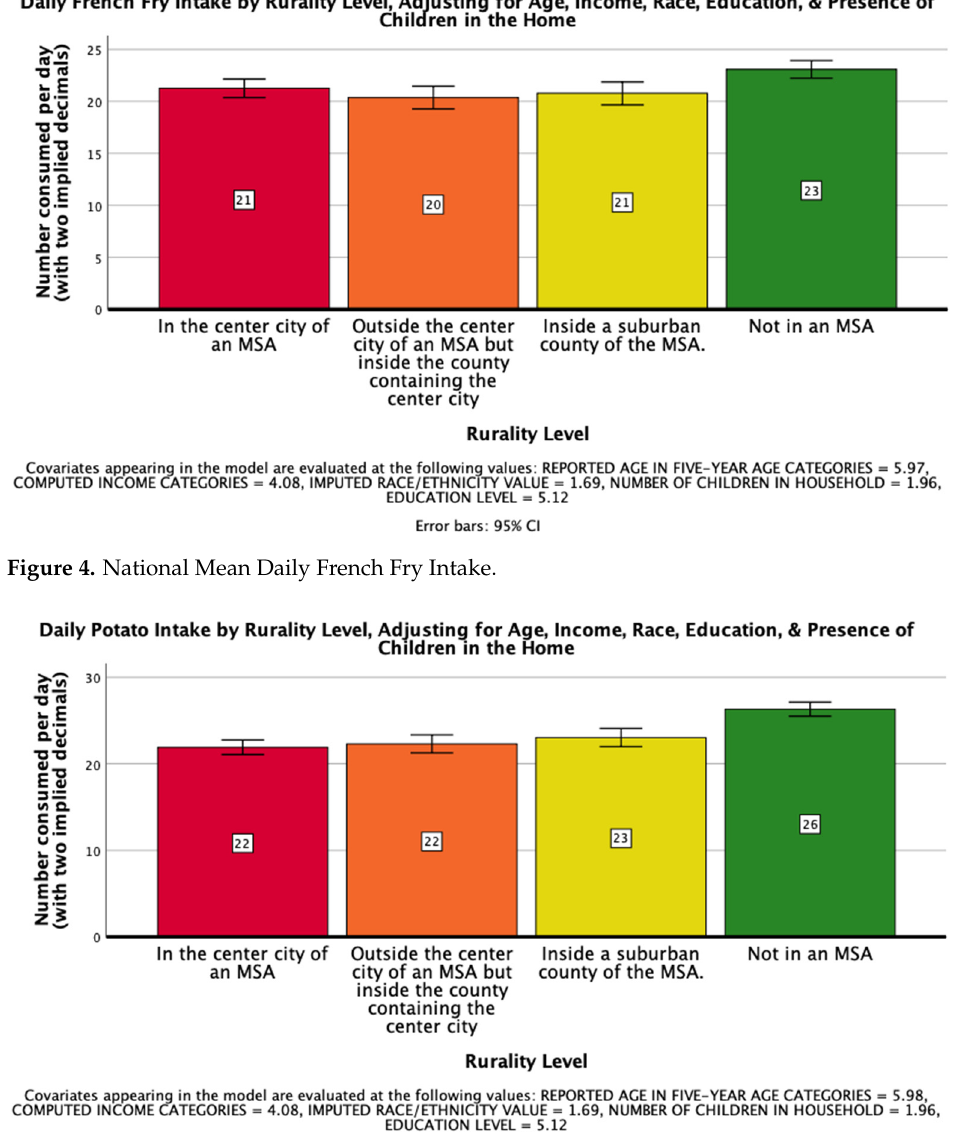
Figure 3. National Mean Overall Daily Fruit Intake.